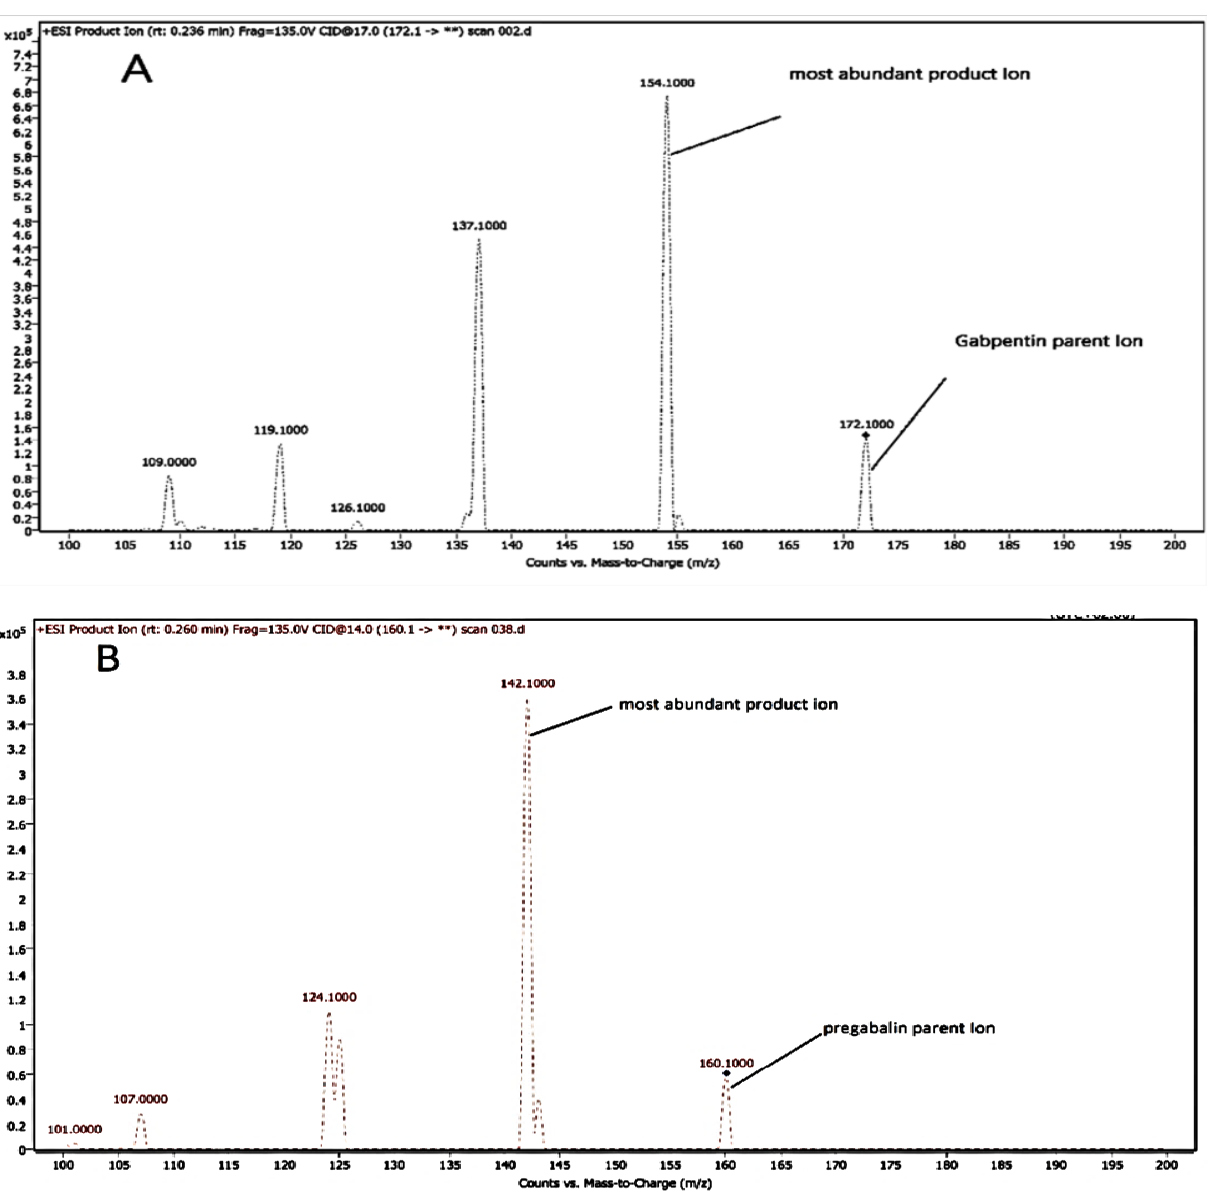
Figure 3. Total ion chromatogram (TIC) of an [M + H] + of GAB ( A ) and PRE, IS ( B ).